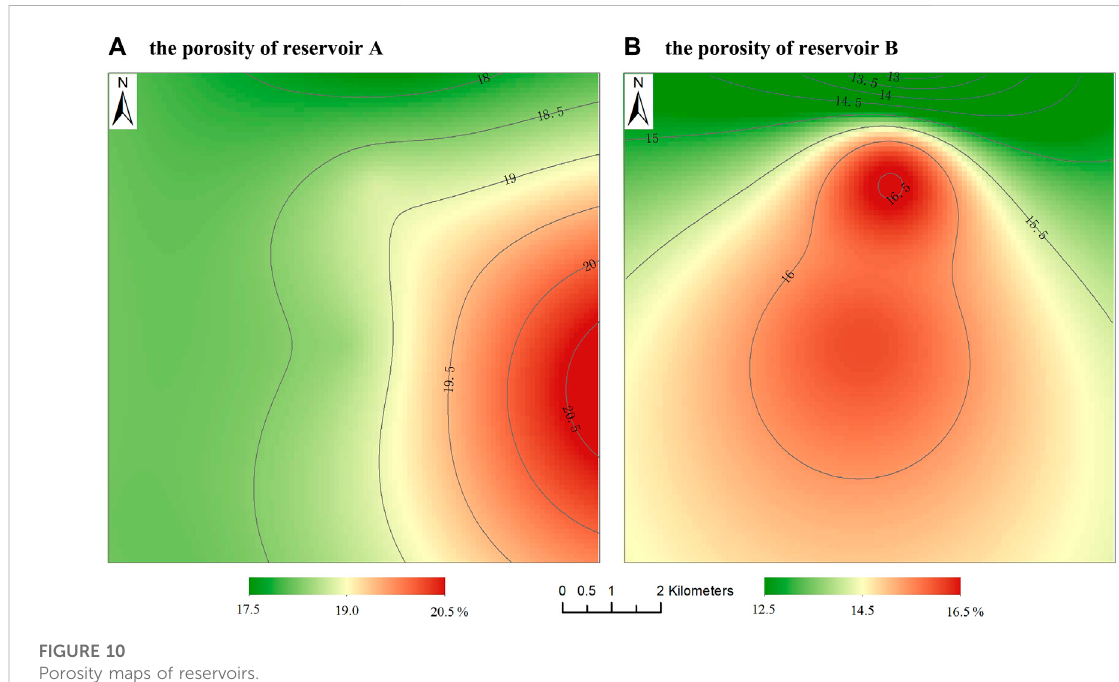
FIGURE 10 Porosity maps of reservoirs.